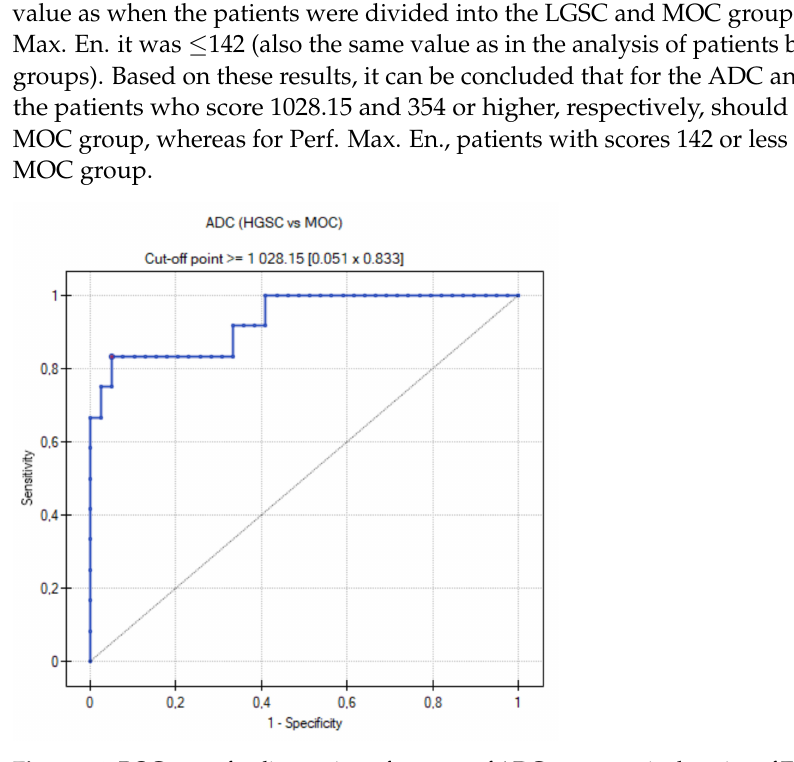
Figure 14. ROC curve for diagnostic performance of ADC parameter in detection of EOC (HGSC vs.